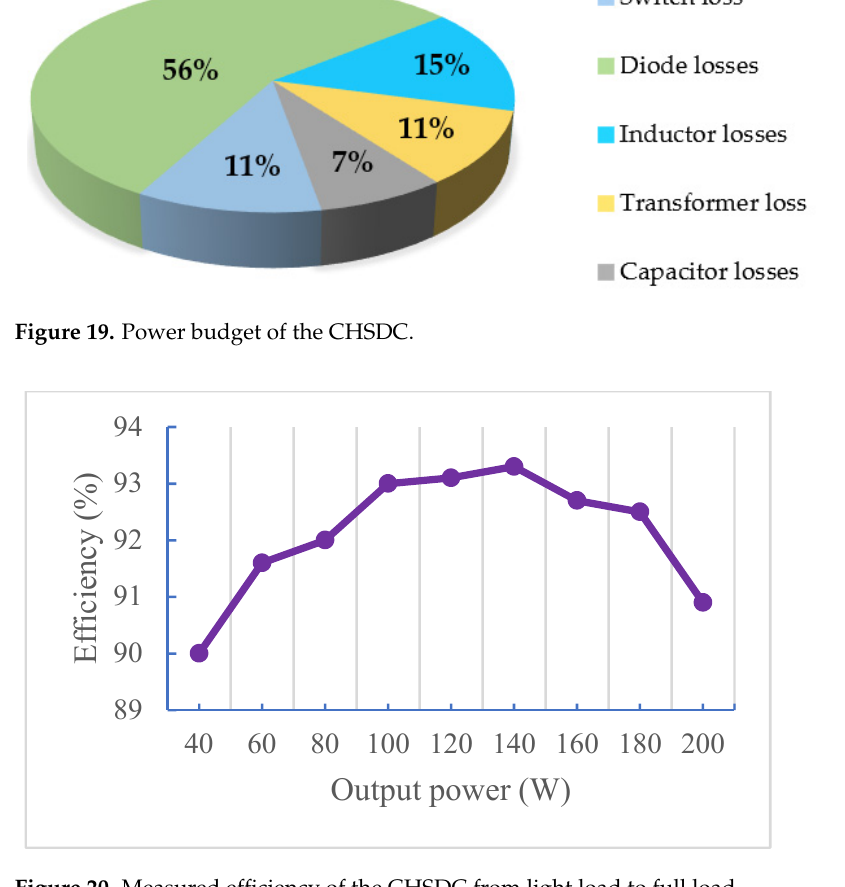
Figure 20. Measured efficiency of the CHSDC from light load to full load.